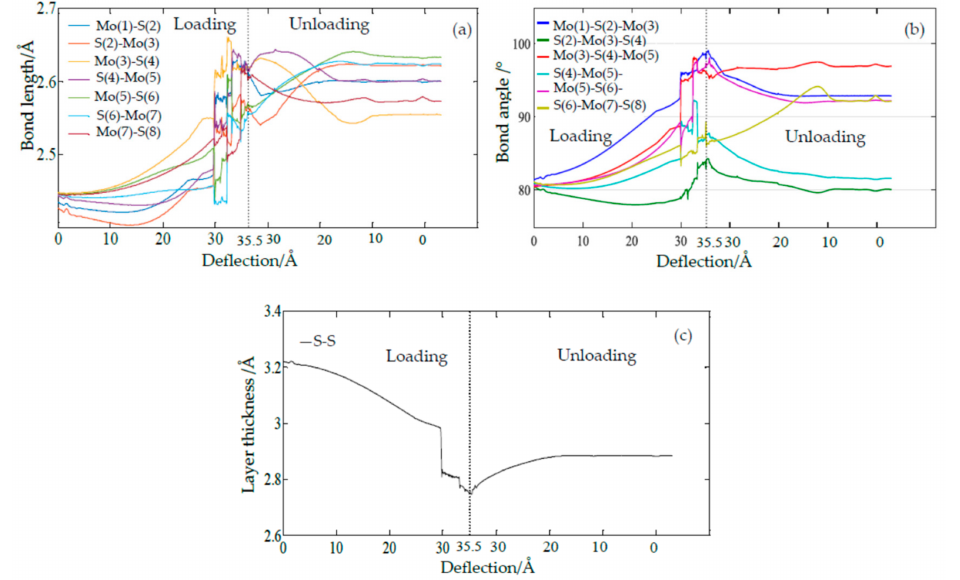
Figure 4. The S–Mo bond lengths ( a ), S–Mo–S bond angles and Mo–S–Mo angles ( b ), and the layer thickness of S–S ( c ) versus deflection during the loading process and unloading process (the labeled atoms are shown in Figure 3).